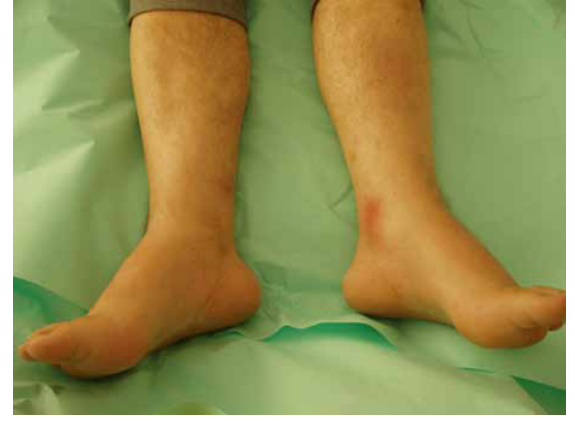
Figure 1. Characteristic eruption of erythema nodosum on the patient’s legs and arthritis of both